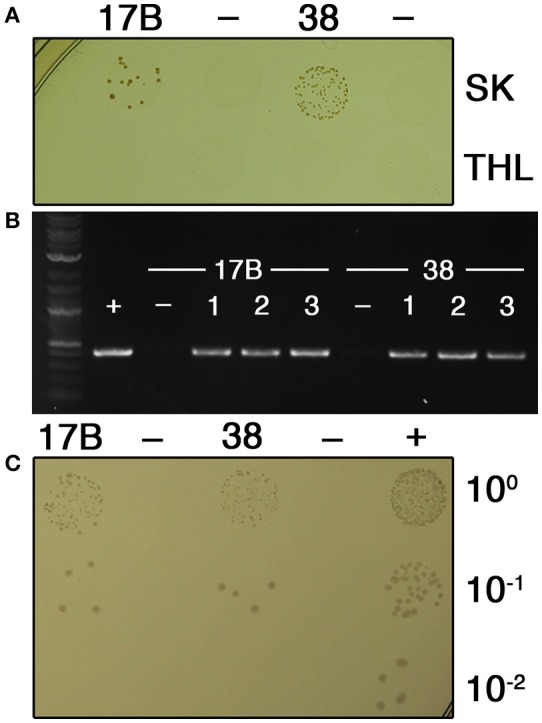
V. parvula clinical isolates exhibit natural competence. (A)
V. parvula strains SKV17B and SKV38 were transformed with the E. coli-Veillonella shuttle vector pBSJL1 in either SK medium (top row) or THL medium (bottom row). Ten microliters of the transformation reaction was spotted onto selective medium to isolate transformants. Samples from left to right are: SKV17B + pBSJL1, SKV17B (no DNA), SKV38 + pBSJL1, and SKV38 (no DNA). (B) Three CFU from the SKV17B and SKV38 transformation plates were tested for the presence of pBSJL1 using plasmid-specific primers. The untransformed parental strains were included as negative controls. (C) Plasmid extraction was performed on confirmed V. parvula transformants as well as the untransformed parental strains and then the resulting samples were transformed into E. coli. Plasmid samples from left to right were purified from the following sources: SKV17B + pBSJL1, SKV17B, SKV38 + pBSJL1, SKV38, and pBSJL1 purified from E. coli.